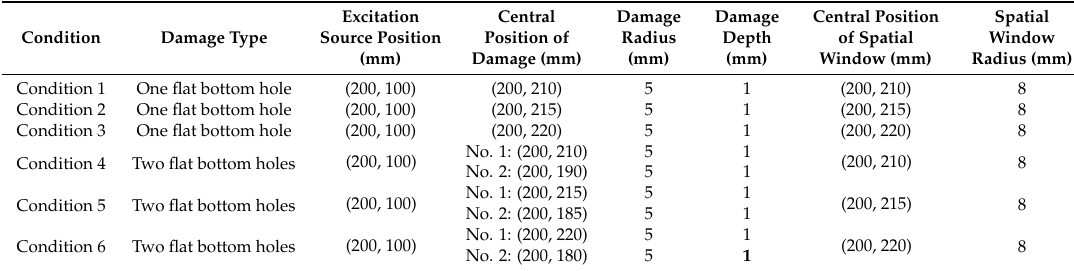
Figure 23. The wavenumber distributions of the spatial window when different conditions are taken into consideration. ( a ) Condition 1; ( b ) condition 2; ( c ) condition 3; ( d ) condition 4; ( e ) condition 5; ( f ) condition 6. The conditions are listed in Table 9. Table 9. The conditions of Figure 23.